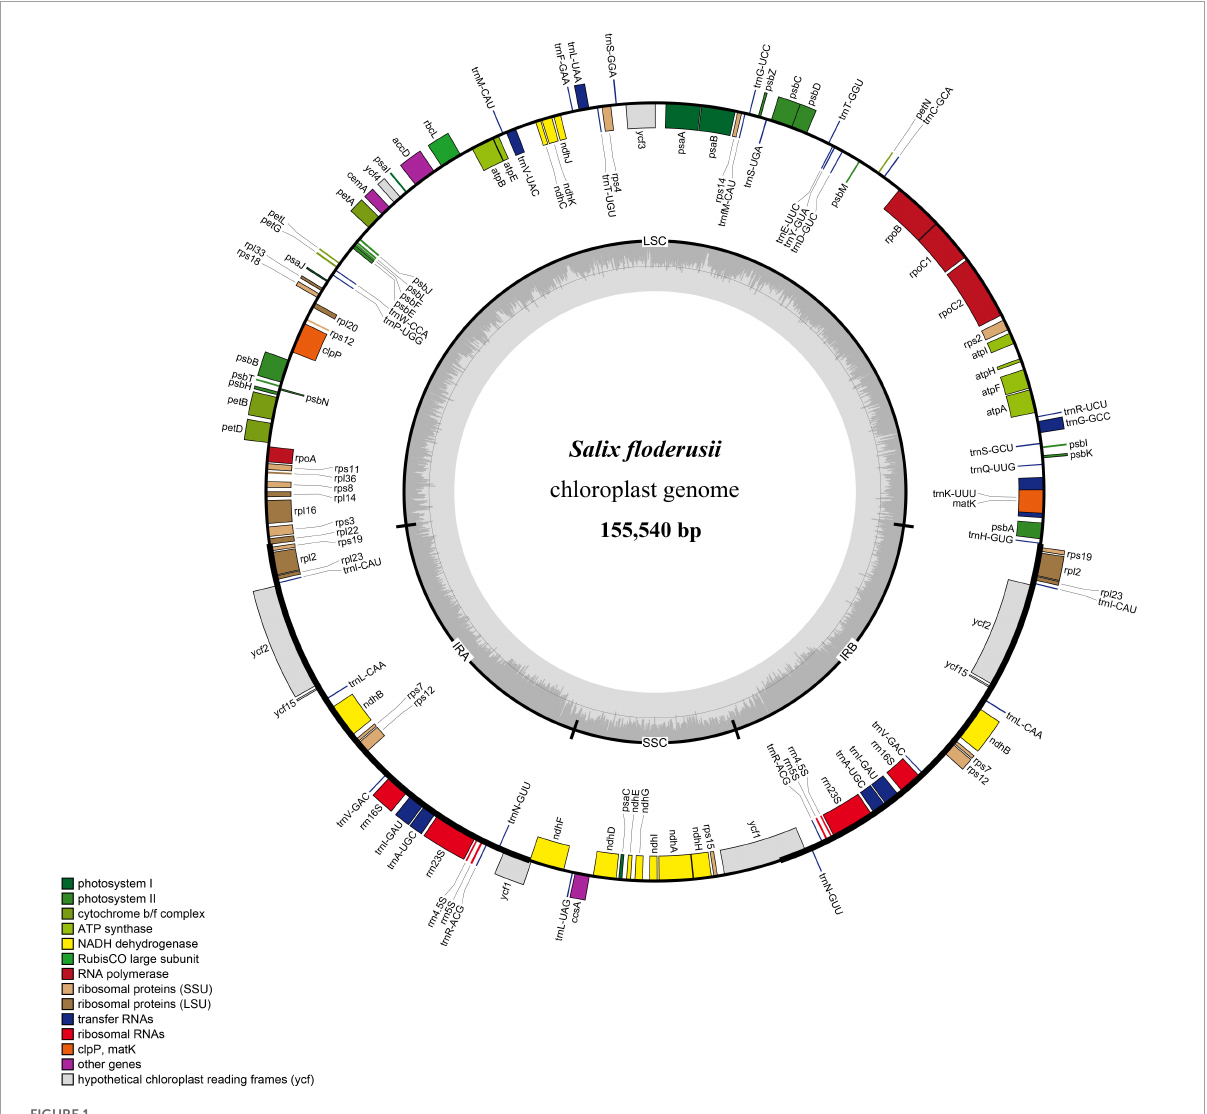
FIGURE1 Gene map of the complete Salix floderusii cp genome. Genes drawn within the circle are transcribed in a clockwise direction, and genes drawn out are transcribed in a counterclockwise